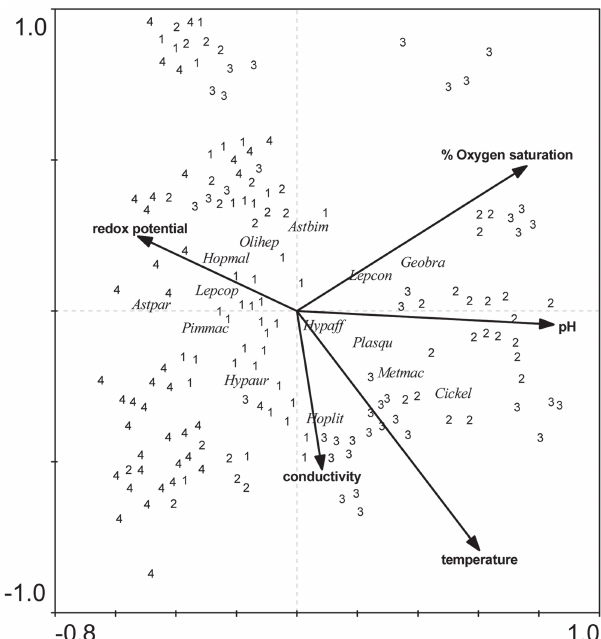
Fig. 4. Ordination diagram from Canonical Correspondence Analysis of the abundance of the 14 most numerous species with abiotic variables. Zone codes: 1 = Zone 1; 2 = Zone 2; 3 = Zone 3; and 4 = Zone 4. Species codes: Aspar = Astyanax parahybae ; Astbim = Astyanax cf. bimaculatus ; Cickel = Cichla kelberi ; Geobra = Geophagus brasiliensis ; Hopmal = Hoplias malabaricus ; Hypaur = Hypostomus auroguttatus ; Hoplit = Hoplosternum littorale ; Hypaff = Hypostomus affinis ; Lepcop = Leporinus copelandii ; Lepcon = Leporinus conirostris ; Metmac = Metynnis maculatus ; Olihep = Oligosarcus hepsetus ; Pimmac = Pimelodus maculatus ; Plasqu = Plagioscion squamosissimus .